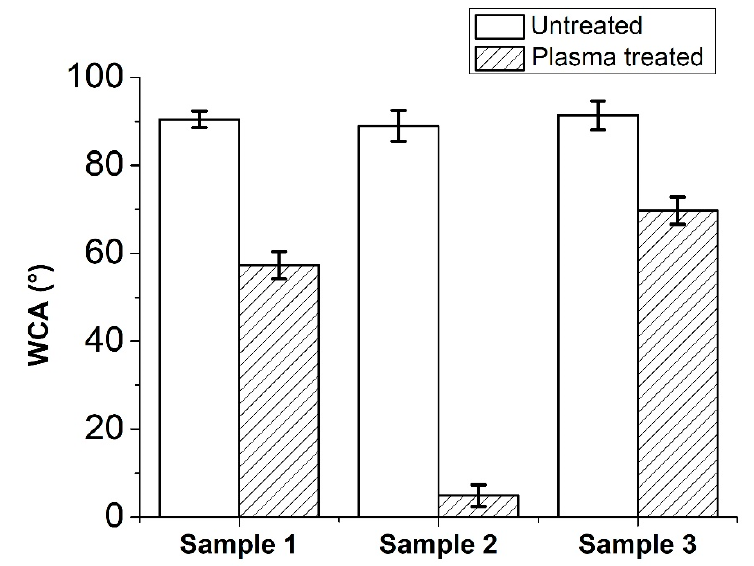
Figure 5. Water contact angle comparison between three samples in untreated and gaseous plasma treated state.